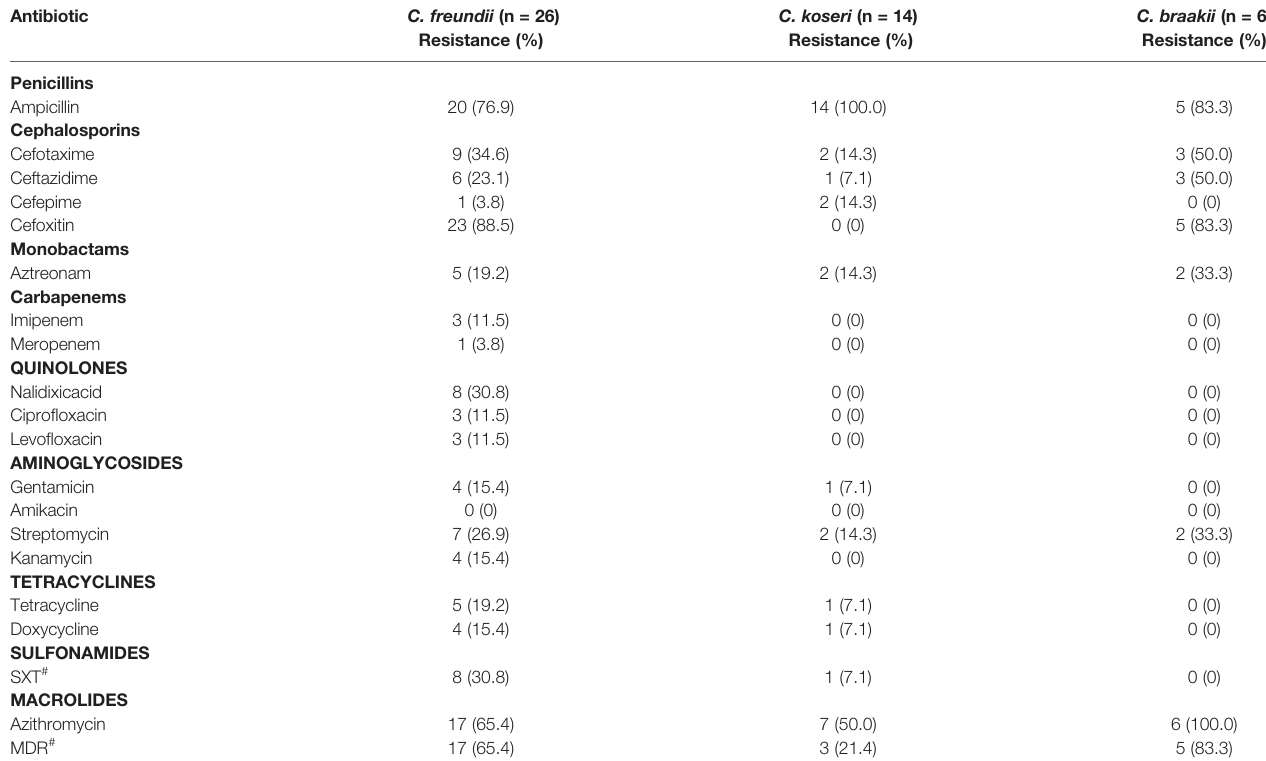
TABLE 3 | Prevalence of resistance to different antibiotics by